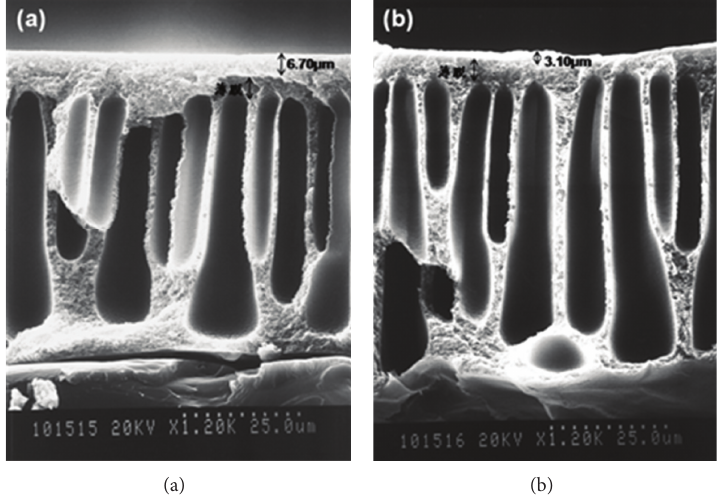
Figure 10: Profile of the UF membrane after ultrafiltration (10KD, magnified 1200x), (a) with 0 wt% TiO 2 and (b) with 10wt% TiO 2